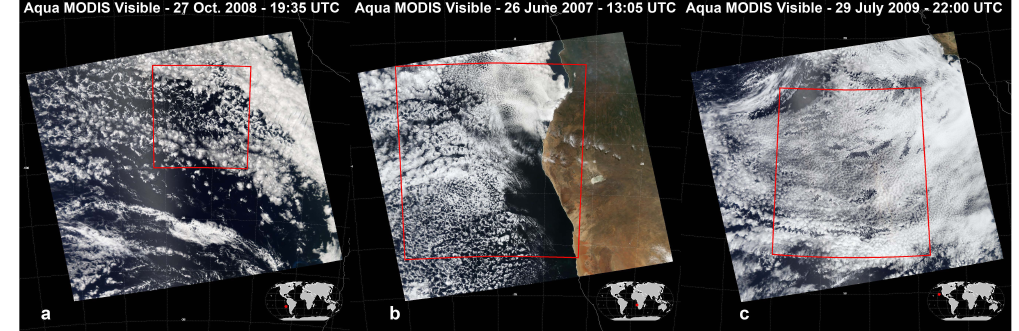
Fig. 4. Aqua MODIS visible quick-look imagery for the areas in Figs. 7, 9, and 10 from left to right (http://modis-atmos.gsfc.nasa.gov/ IMAGES/index myd021km.html). (a) is for the southeast Pacific on 27 October 2008 at ≈ 19:35UTC. (b) is for the southeast Atlantic on 26 June 2007 at ≈ 13:05UTC. (c) is for the northeast Pacific on 29 July 2009 at ≈ 22:00UTC. The red boxes denote the areas of interest for the scenes in question.